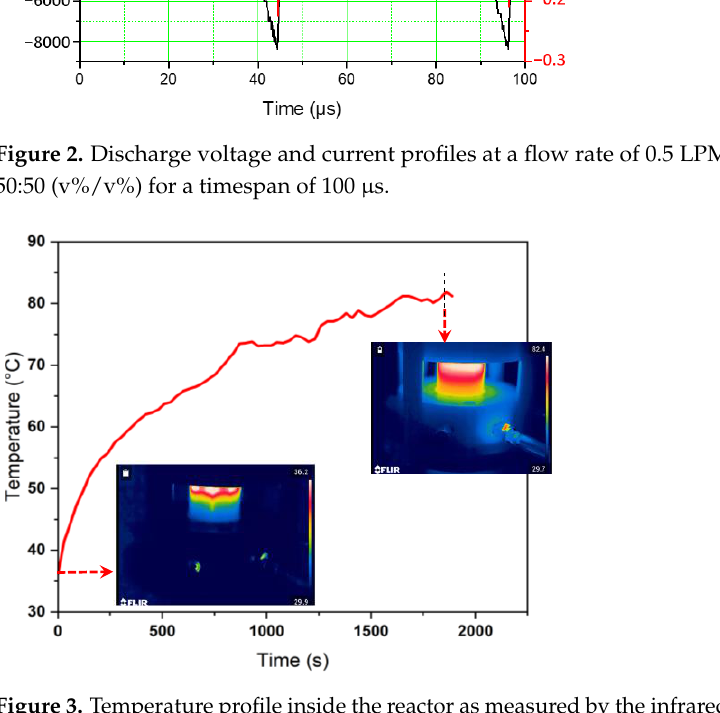
Figure 3. Temperature profile inside the reactor as measured by the infrared camera when a CH 4 :CO 2 ratio of 75:25 (v%/v%) at 0.5 LPM was used. The snapshots of the reaction zone at 0 min and 30 min are depicted in the inset